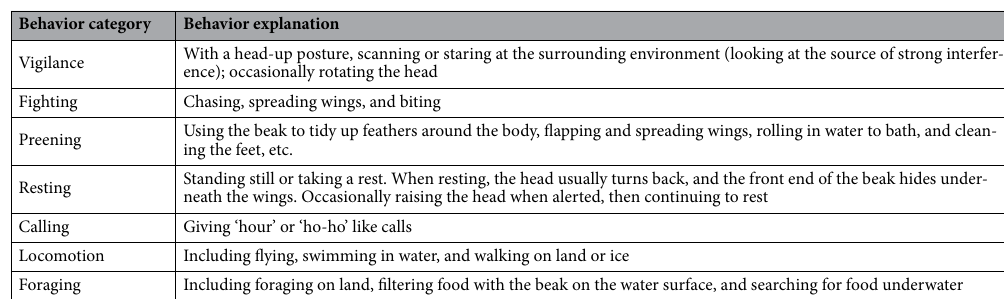
Table 6. Definitions of seven behaviors observed in wintering whooper swans at Sanmenxia Wetland in western Henan Province, China 61 .